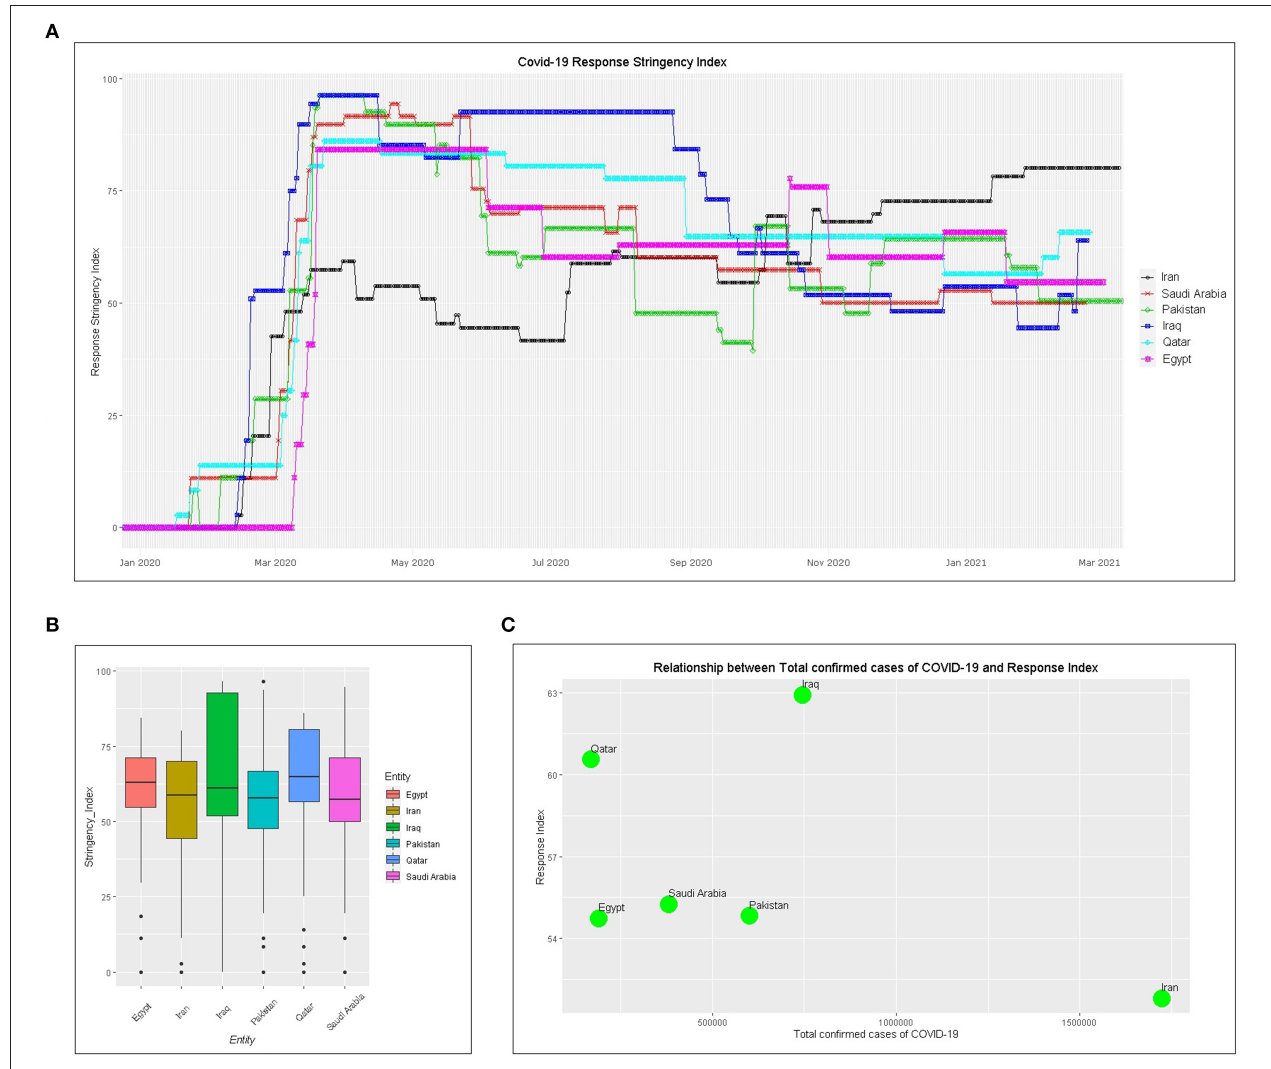
FIGURE 3 | Government intervention index and its relationship to confirmed cases: (A) government or societal intervention index, (B) bar plot of intervention score since January 2020, and (C) relationship between government response index and the number of confirmed